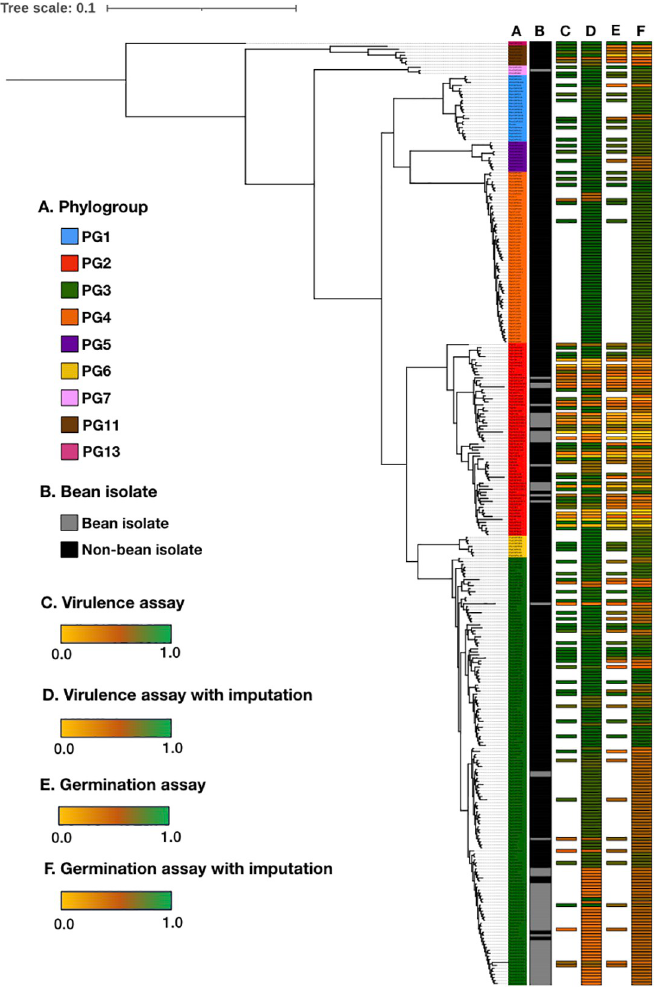
Fig 7. Core genome phylogeny of 320 P . syringae isolates. Leaf colors represent PG affiliation as shown in the legend. (A) Bean isolates in gray and non-bean isolates in black. (B) Normalized median bean weight after seed infection by the respective isolates. Green indicates a high weight, while yellow indicates a low weight as show in the legend. (C) Normalized median bean weight for the expanded strain collection based on phylogenetic imputation. (D) Normalized median germination frequency after seed infection by the respective isolates. Green indicates a high frequency, while yellow indicates a low frequency as show in the legend. (E) Normalized median germination frequency for the expanded strain collection based on phylogenetic